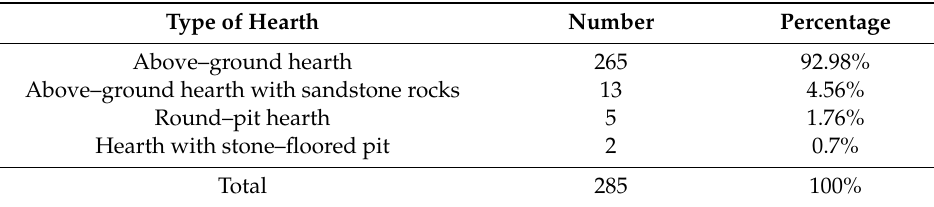
Table 5. Hearths in the Shizitan site, Locality S29